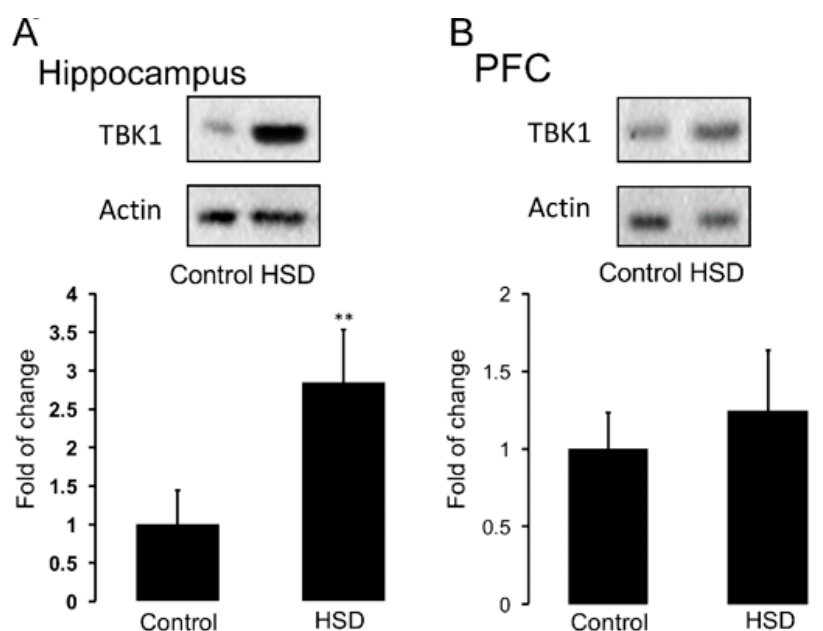
Figure 5. HSD diet exposure during pregnancy and lactation increases TBK1 protein levels in hippocampus. HSD exposure during embryonic development was performed as described. Total protein of TBK1 inflammatory marker in hippocampus ( A ) and PFC ( B ) was determined by Western blot analysis as described in Materials and Methods. Graphs show mean ± SD; n = 5–8. Unpaired Student’s t-test comparing between groups, ** p < 0.01.